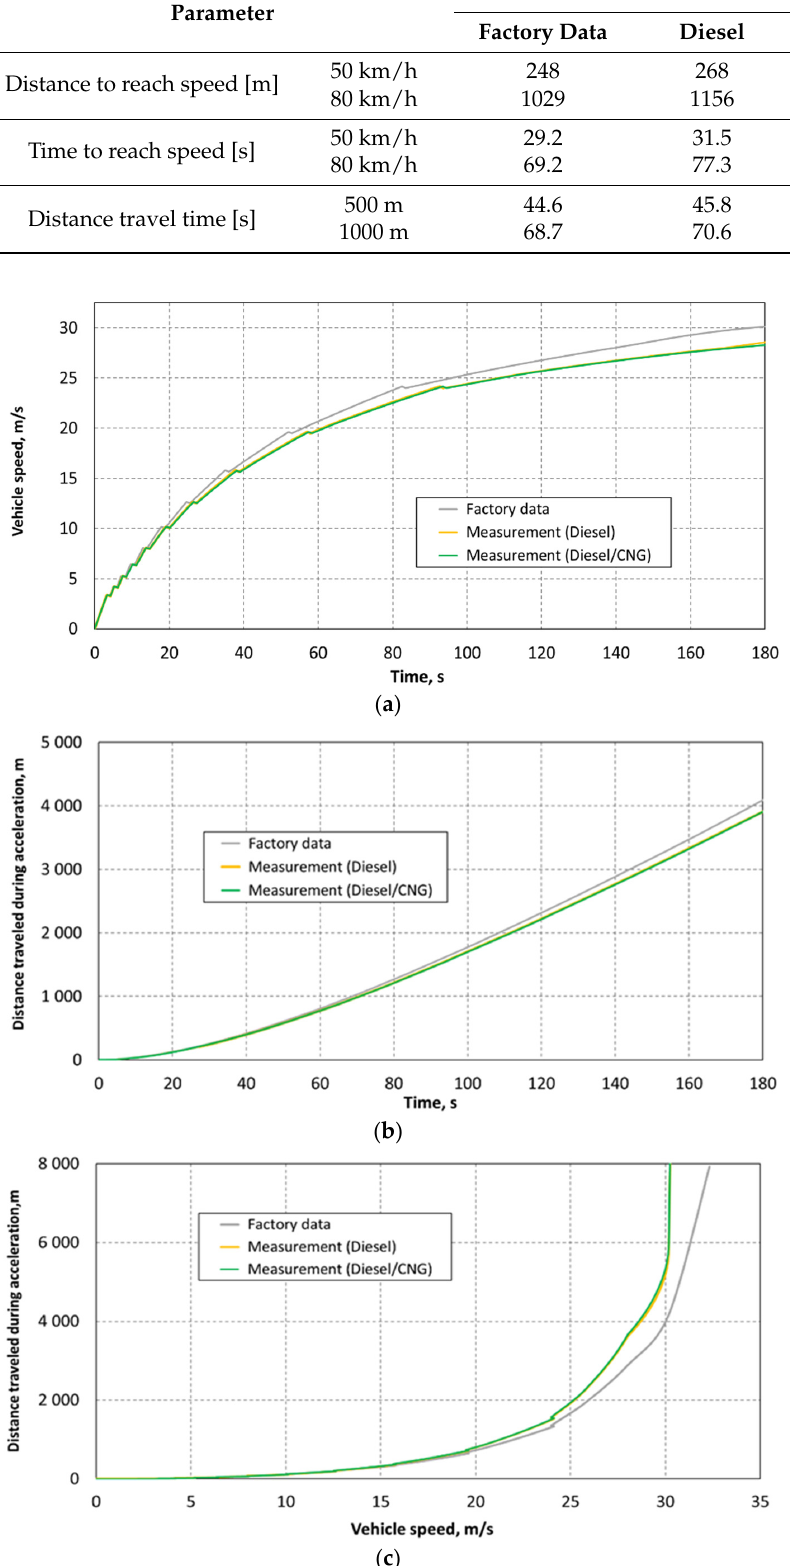
Figure 12. Time ( a ), distance ( b ) and speed during acceleration of the vehicle set ( c